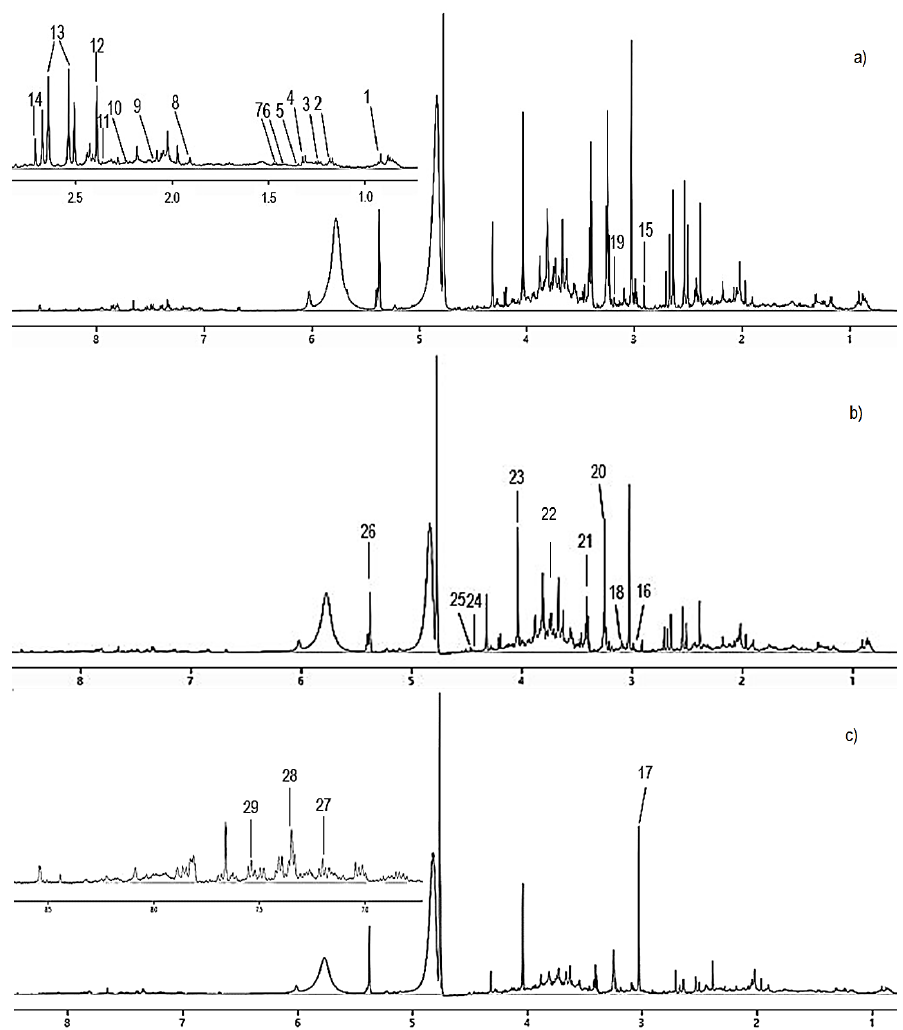
Figure 1. The representative of 1H NMR spectra of urine samples of normal group ( a ), hypercholesterolemic positive control group ( b ), and hypercholesterolemic rats treated with 2% DDP group ( c ). 1: